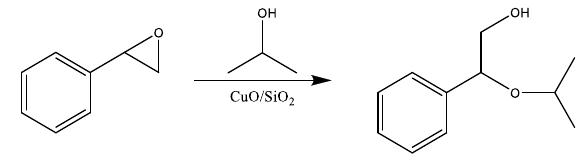
Figure 4. Styrene oxide alcoholysis with 2-propanol.